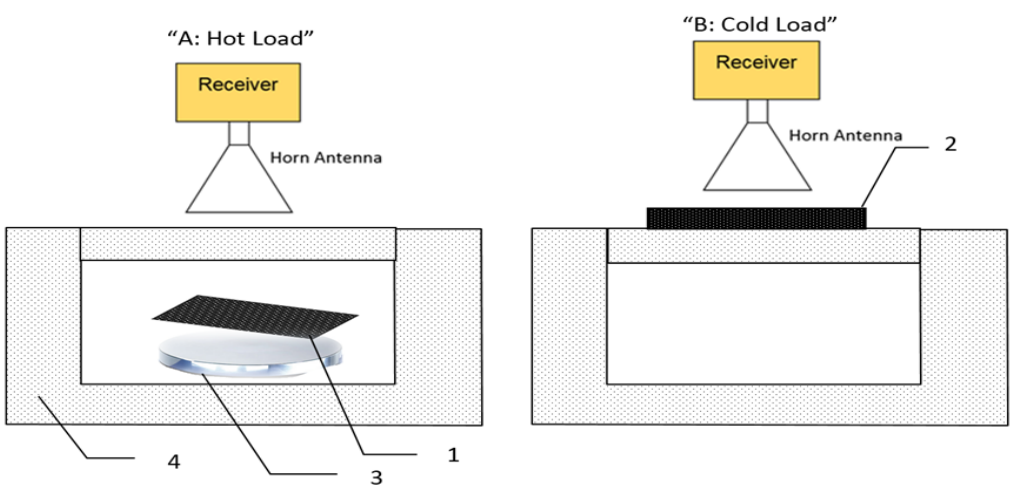
Figure 4. Radiometric emission centered at 90 GHz is collected by a moveable horn antenna at positions: A to measure a hot calibration source ( 1 ) (carbon loaded foam absorber; type: Eccosorb AN- 73) stabilized at a temperature ~54 °C using a digital hotplate ( 3 ) placed in a polystyrene foam bucket ( 4 ), B to measure the cold calibration source ( 2 ) (carbon loaded foam absorber; type: Eccosorb AN-73) in thermodynamic equilibrium with air temperature ~20 °C.